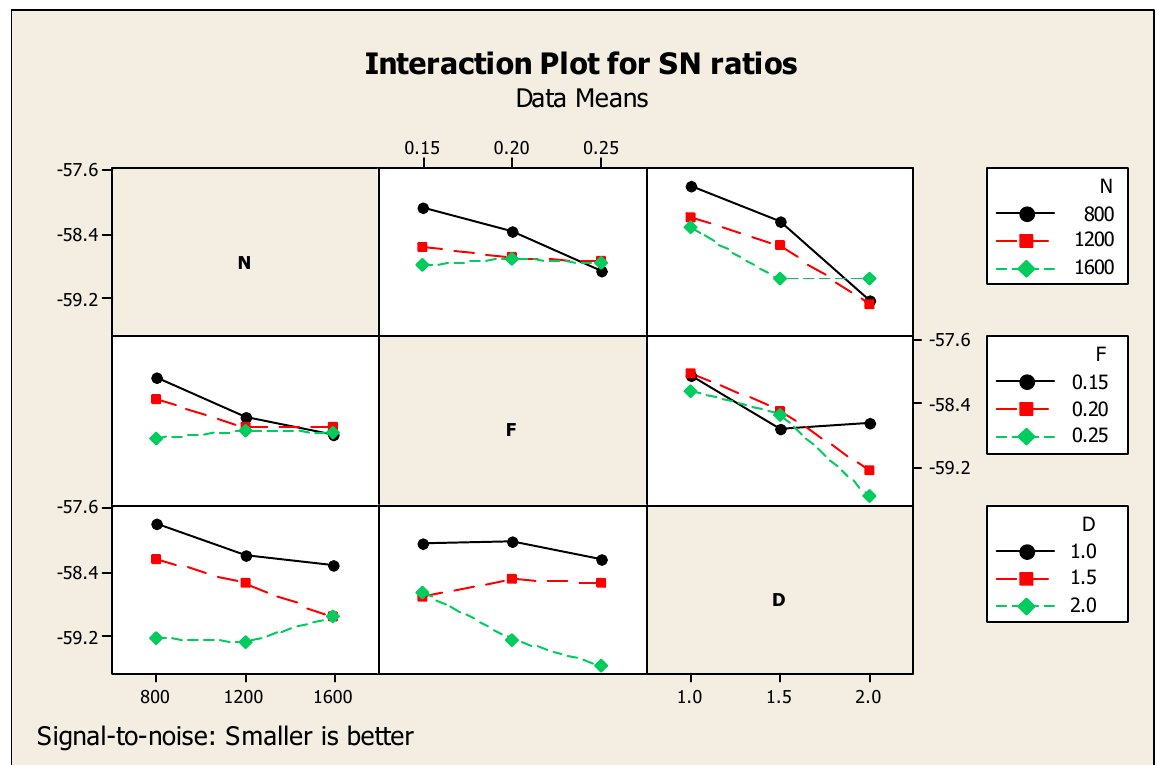
Figure 10. CF interaction